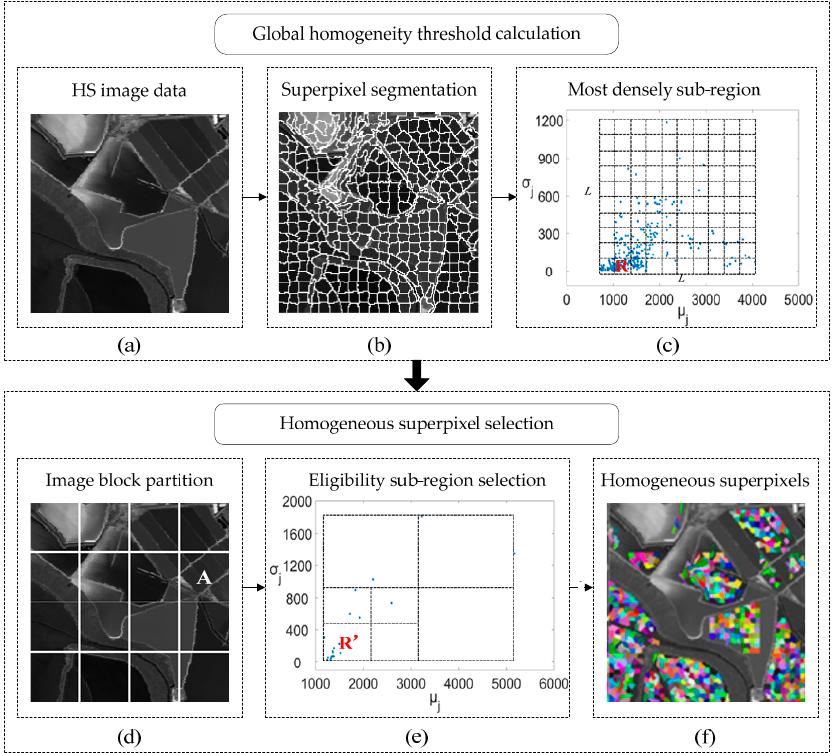
Figure 2. The processing flow of the proposed automated scatter-plot-based homogeneous superpixel selection algorithm. ( a ) The input HS image data (one spatial band); ( b ) the superpixel segmentation result; ( c ) the most dense sub-region in the scatter plot; ( d ) the image block partition result; ( e ) the eligibility sub-region in the scatter plot of block A ; ( f ) the homogeneous superpixels selection results of the whole image.